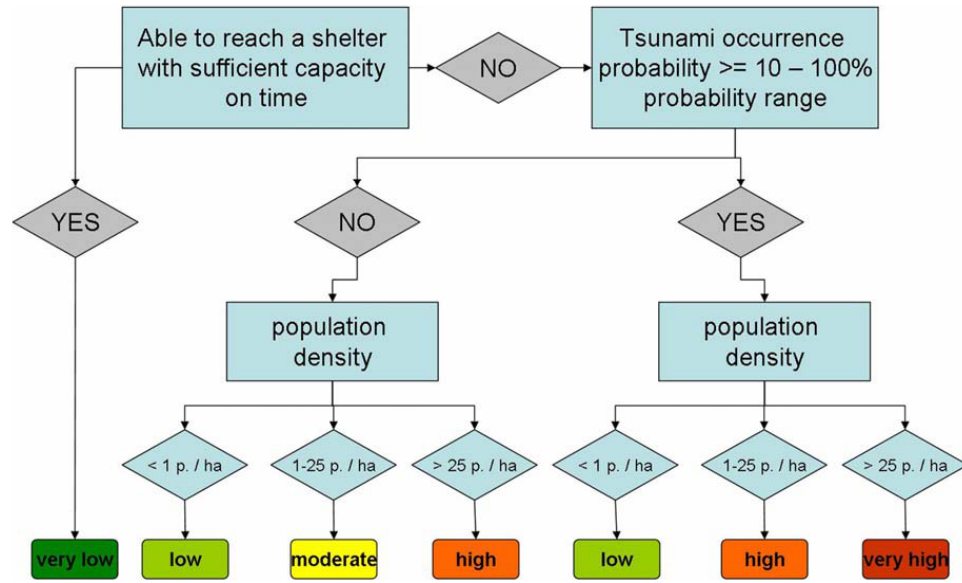
Fig. 8. Decision tree approach to assign tsunami risk